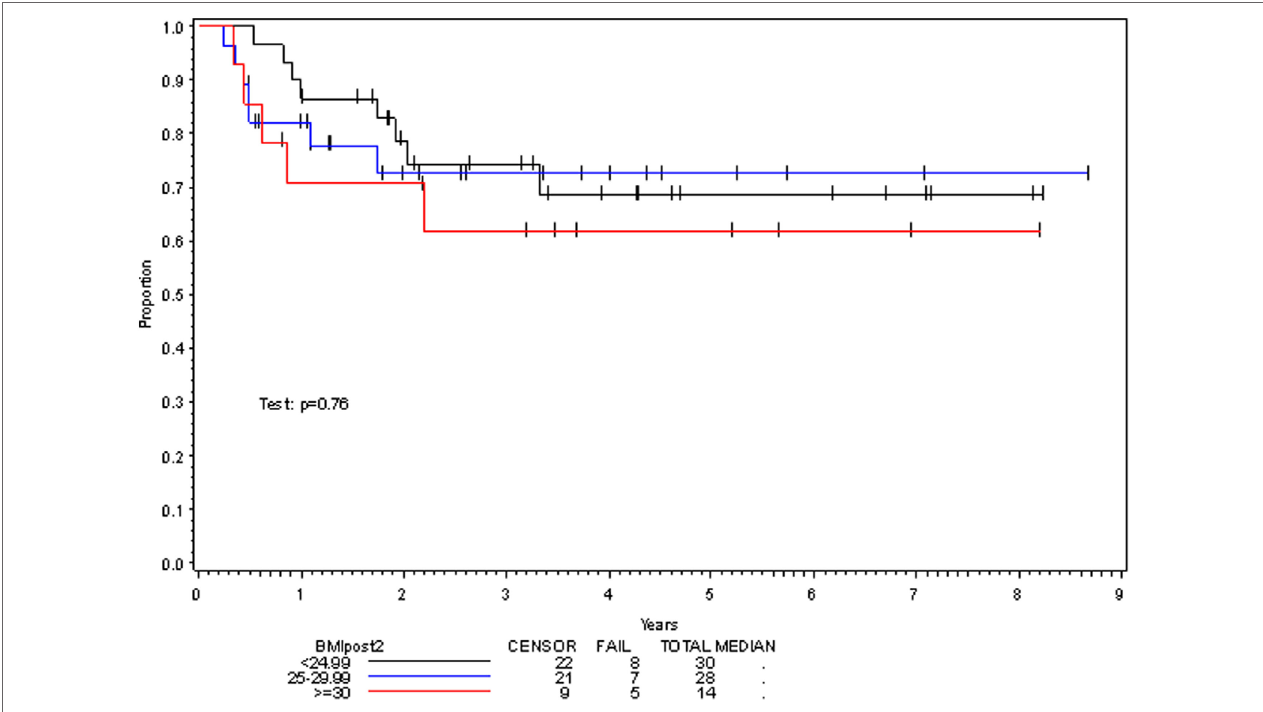
FigUre 1 | Disease-free survival per posttreatment BMI category.